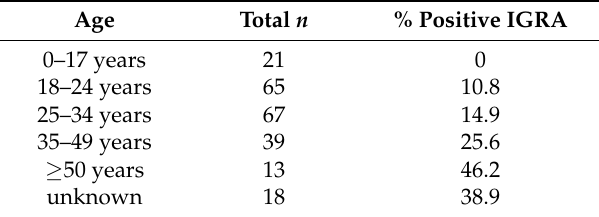
Table 1. Rate of positive IGRA test results in age-specific subgroups of the analyzed refugee cohort.